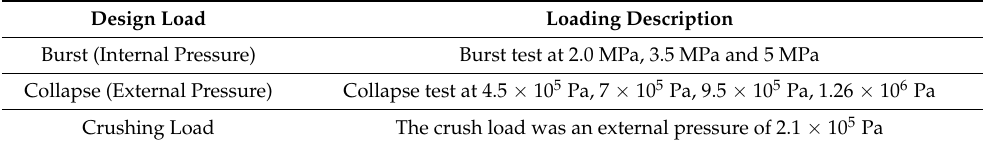
Table 4. Design load